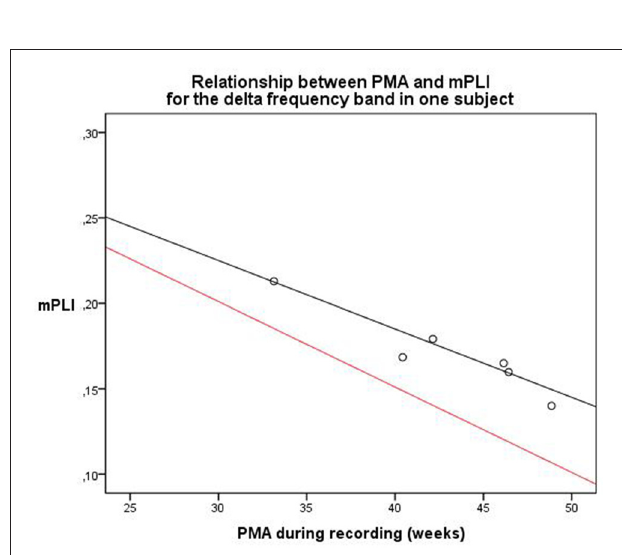
FIGURE 5 | Relationship between PMA and mPLI in the delta frequency band in one subject at six different time points. The equation line of the resulting linear regression model is shown in black. The equation line of the regression model of the relation between PLI and PMA of the total group, based on the cross-sectional data, is shown in red as a reference. PMA = postmenstrual age, mPLI = mean phase lag